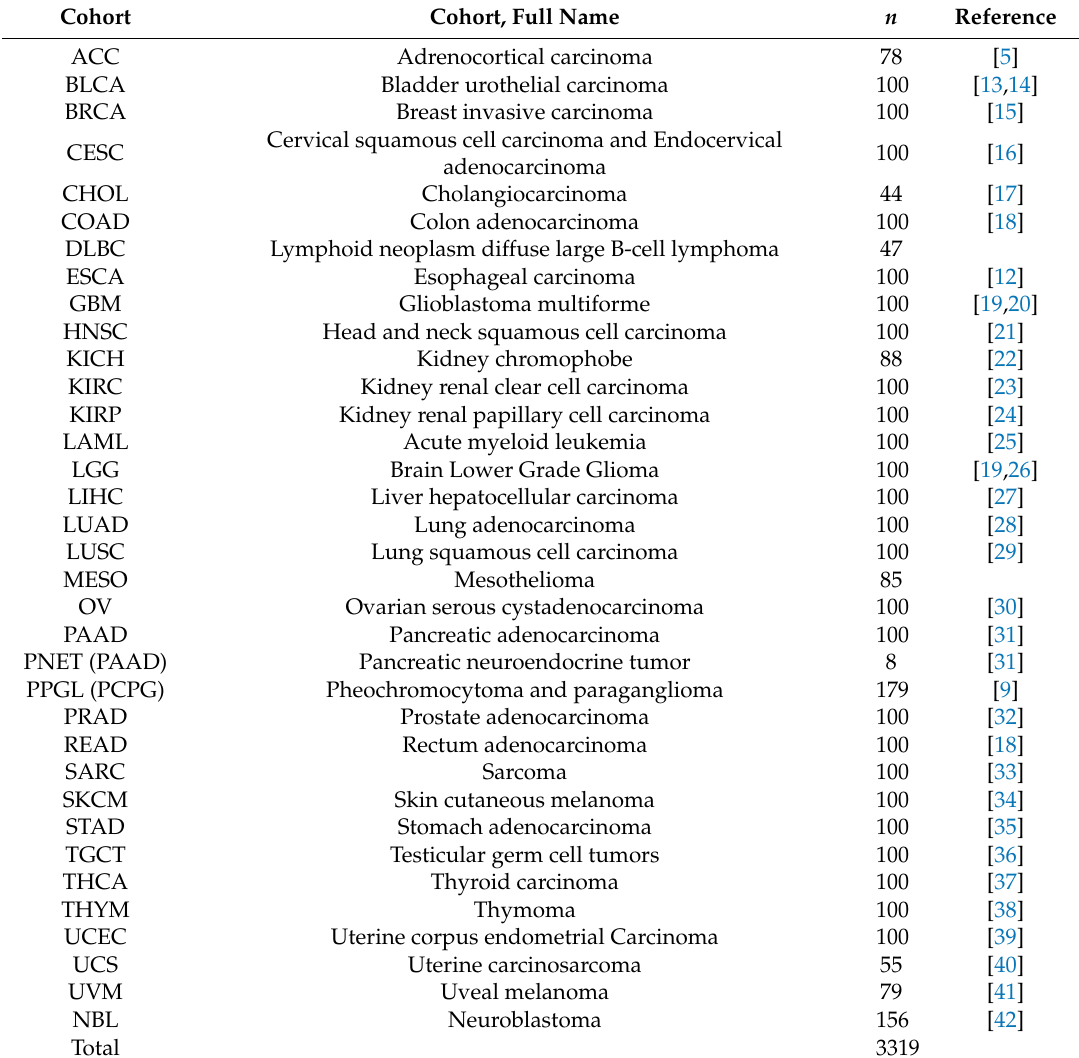
Table 1. Samples included from the Cancer Genome Atlas (TCGA) and Therapeutically Applicable Research To Generate Effective Treatments (TARGET). TCGA official nomenclature is shown in parentheses. n , number of cases included; ref,